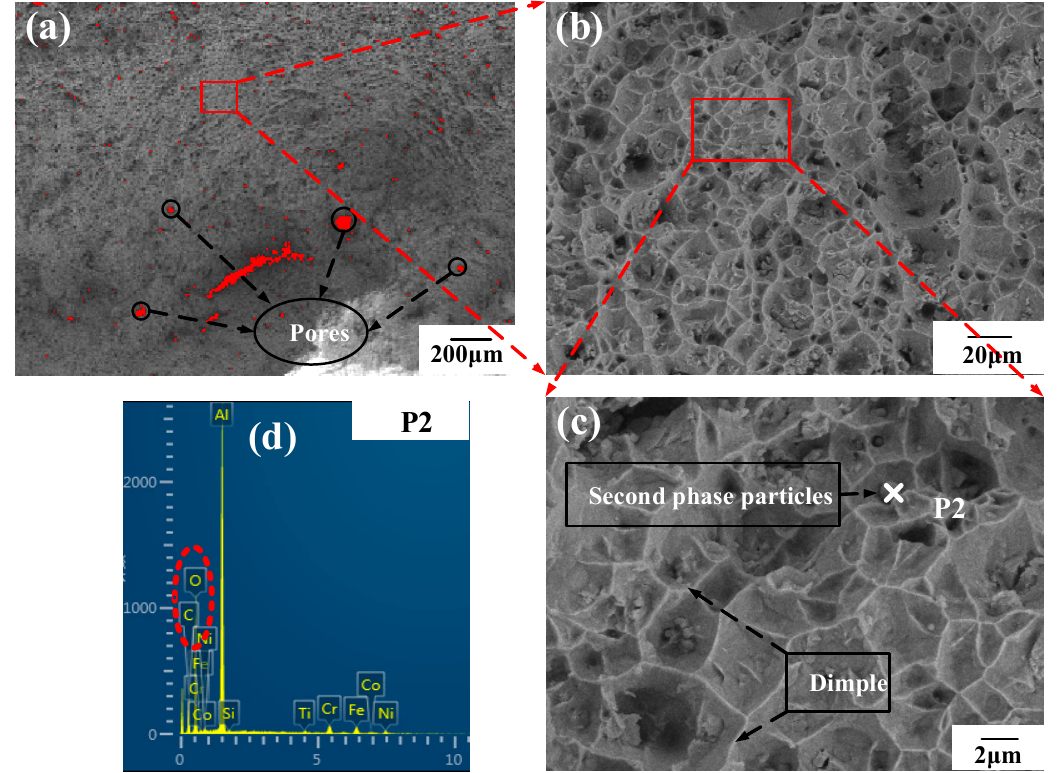
Figure 13. Microscopic fracture morphology and energy spectrum analysis of FGM tensile specimens at: 300 °C: ( a ) SEM 20×; ( b ) SEM 200×; ( c ) SEM 1000×; ( d ) test point P2 element content.